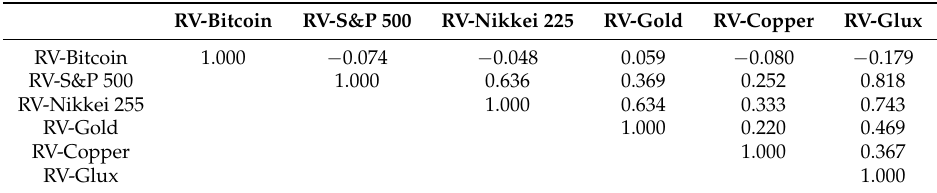
Table 2. Contemporaneous correlations between monthly realized